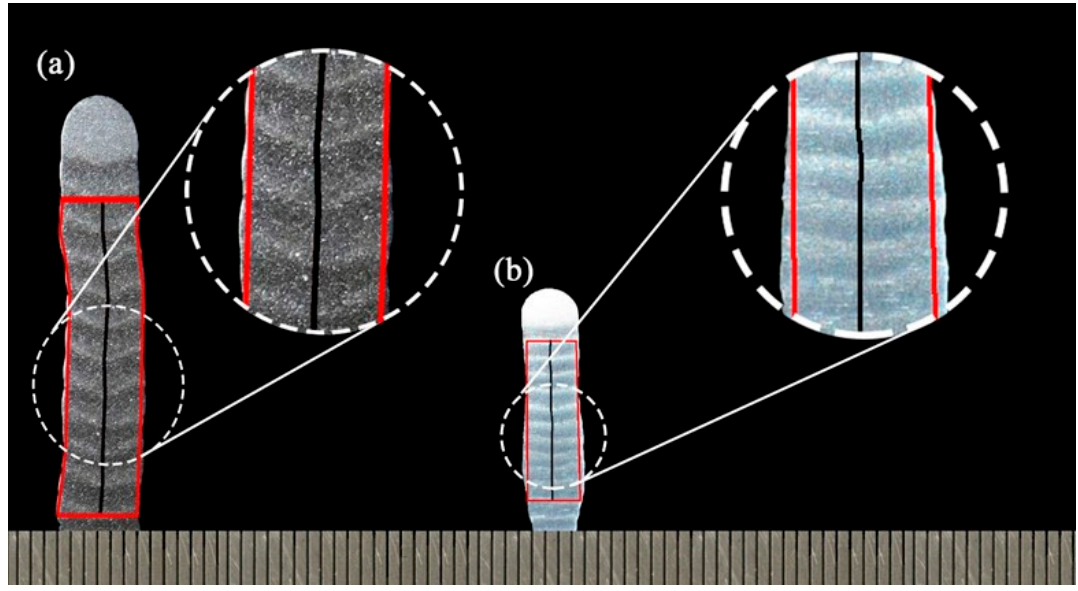
Figure 8. Magnifications of the cross-sections of the 2 WAAM 14-layer high walls using the lower and upper values of the deposition speed range: ( a ) lower speed limit (42 cm/min); ( b ) upper speed limit (175 cm/min).